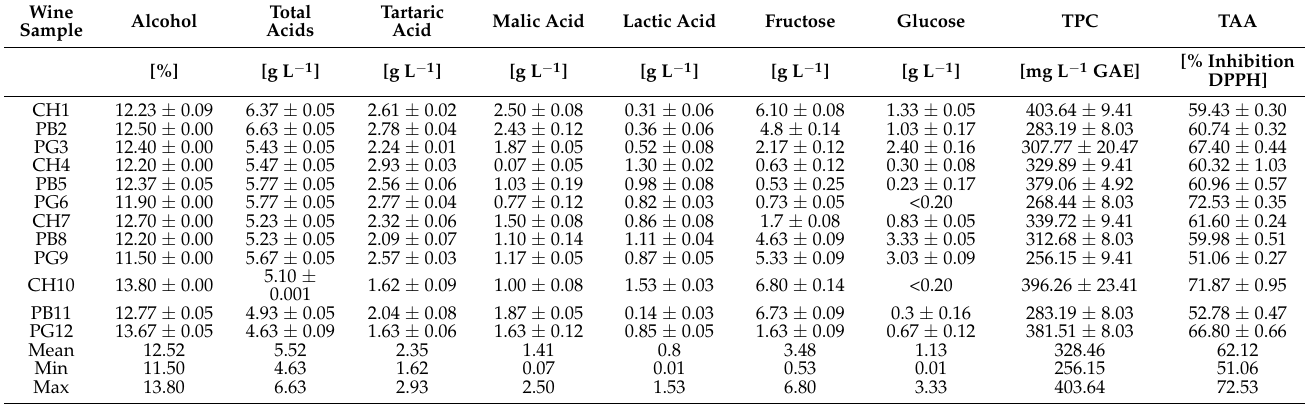
Table 2. Characterization of chemical composition of monovarietal